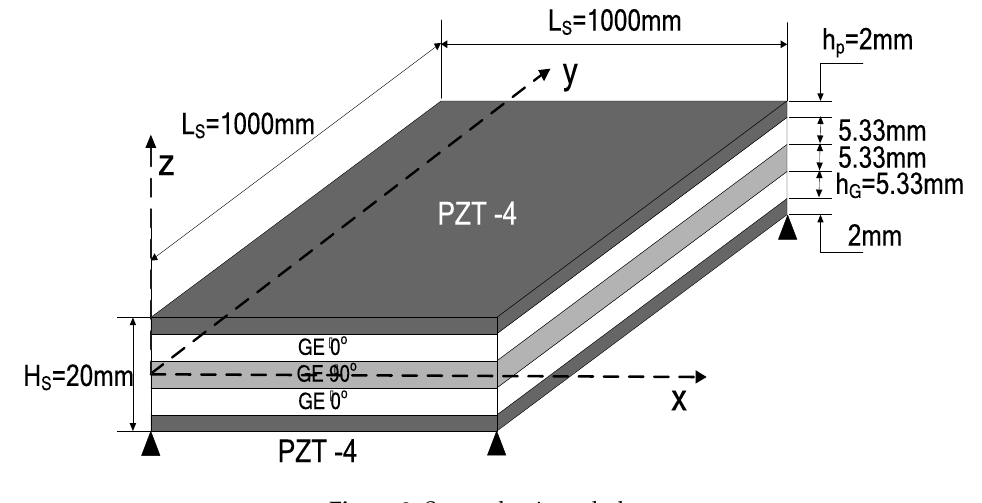
Figure 2. Square laminated plate. Table 1. Properties of the graphite-epoxy (GE) composite material and the piezoelectric material.